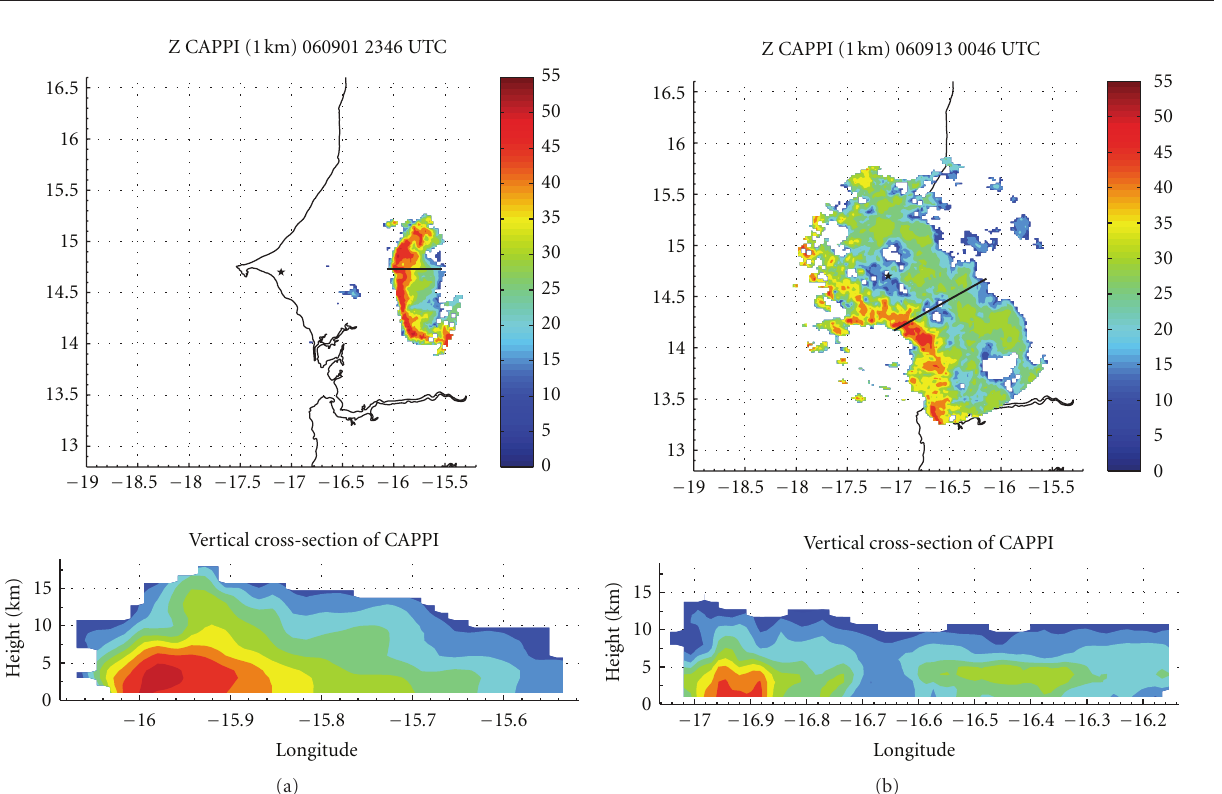
Figure 10: Constant altitude plan position indicator (CAPPI) and associated vertical cross-section of NPOL radar reflectivity for (a) 23:46 UTC on 01 September 2006 and (b) 00:46 UTC on 14 September 2006. Reflectivity is contoured every 5dBZ and the emboldened line located on the CAPPI represents the location of the cross-section. The star indicates the location of NPOL. These times signify the period of greatest organization of the respective squall